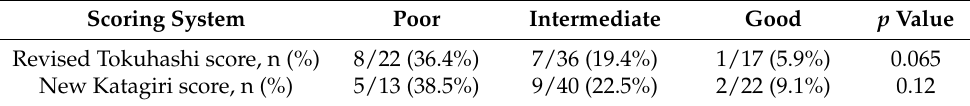
Table 2. Relationship between the predictive prognostic scores with 6–month mortality.